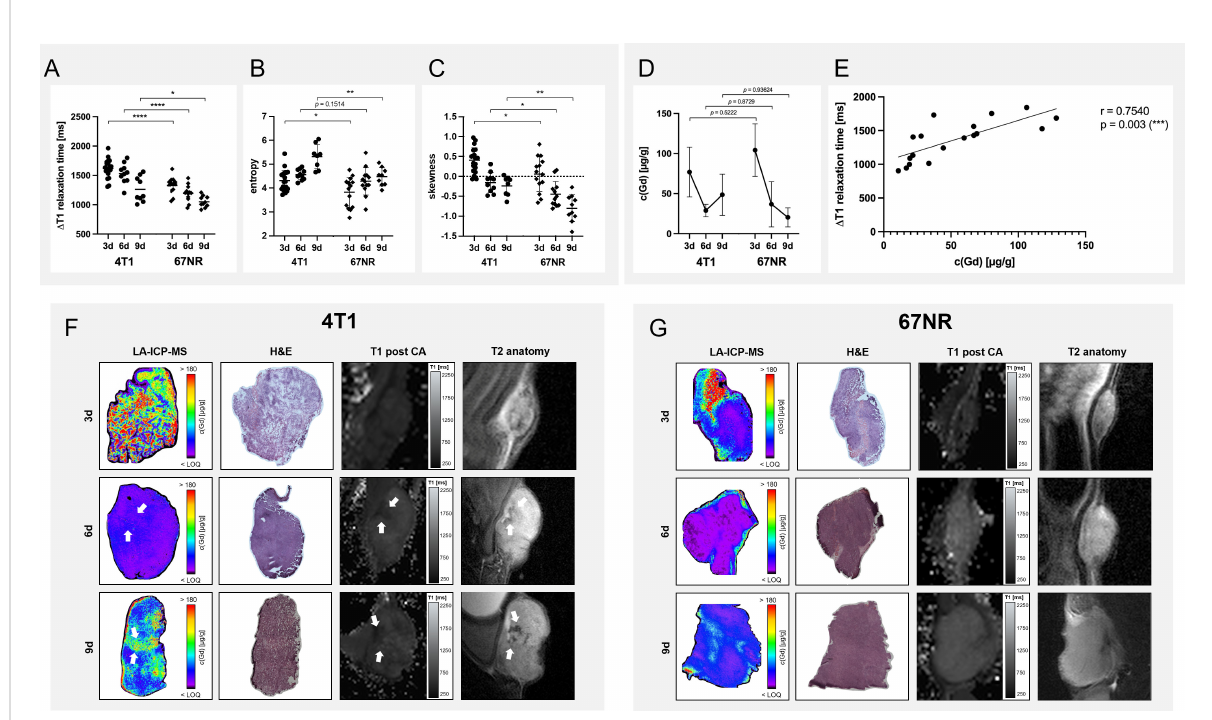
FIGURE 6 Analysis of contrast agent retention with MRI and LA-ICP-MS. Analysis of the delta T1 relaxation times (A) before and after injection of albuminbinding gadofosveset revealed a higher retention in 4T1 tumors in comparison to 67NR tumors, while both showed a decreasing accumulation of the contrast agent over time. Histogram analysis revealed a higher entropy (measure of gray-level distribution, (B) and skewness (asymmetry of probability distribution, (C) of 4T1 tumors than 67NR tumors. While the entropy increased during tumor progression for both tumor models, skewness decreased similarly for 4T1 and 67NR tumors. LA-ICP-MS showed a decreasing gadolinium retention in both tumor models over time (D) , with however non-signi fi cant differences between 4T1 and 67NR tumors, most likely due to intra- and intertumoral heterogeneity. Correlation between the values (E) showed a good correlation with signi fi cant results. Exemplary images of LA-ICP-MS, corresponding H&E and T2 and post-contrast T1 weighted MR images show a more heterogeneous distribution of gadolinium retention in 4T1 tumors ( F , arrows), with necrotic areas that can be correlated between LA-ICP-MS, H&E and MRI, albeit not the exact same slices were analyzed. 67NR tumor were more homogeneous, without these focal necrotic areas (G) . Mean values of the ROI covering the tumor in single slice imaging are shown, details can be found in Supplementary Table 1. * p < 0.05, ** p < 0.01, *** p < 0.001, **** p < 0.0001, CA – contrast